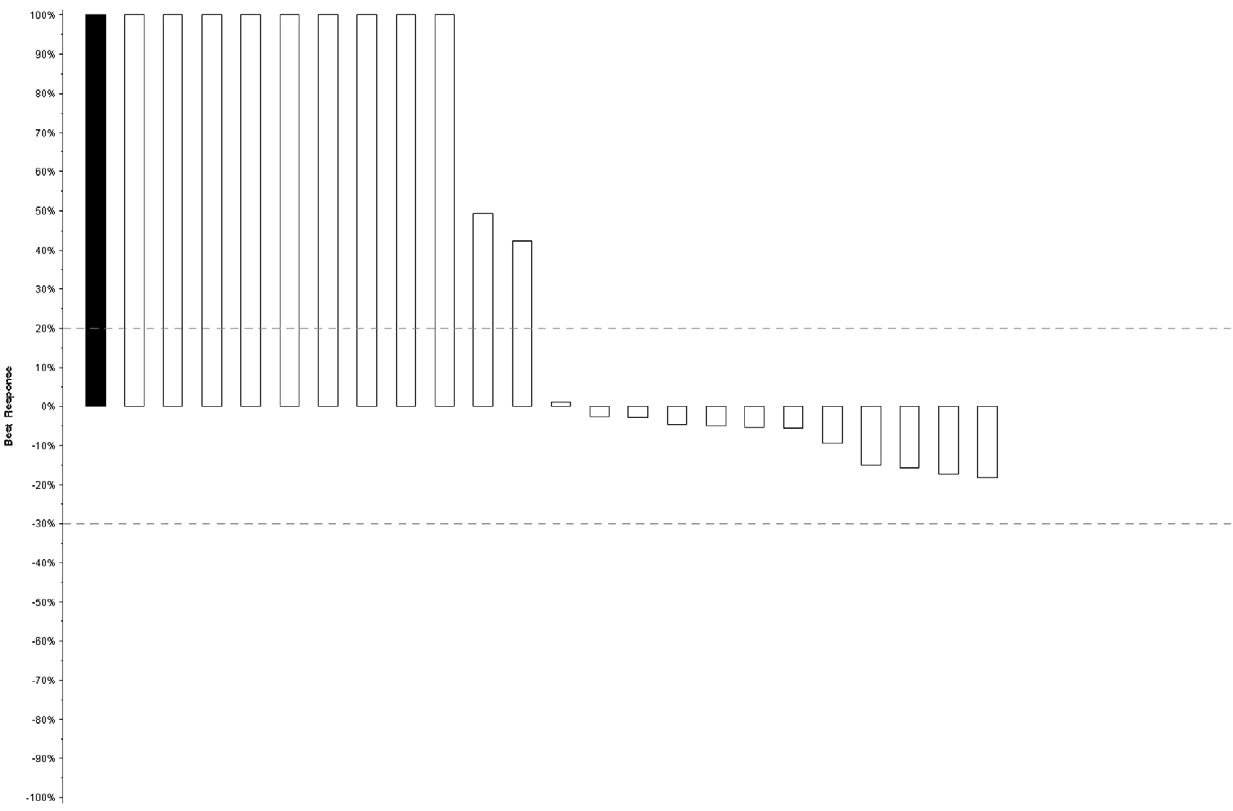
Figure 1. Best tumor response (waterfall plot) in evaluable patients (n=24). The bars on each plot represent the largest decrease under baseline of the sum of longest diameters of all target measurable lesions, or if no decrease was observed, the smallest increase in the sum of longest diameters of target measurable lesions. Patients whose best response was progression due to new lesions, death (due to disease), or clear worsening of non-measurable disease are represented by a bar showing a 100% increase. In addition, patients whose best response could not be determined due to inadequate assessment are represented on the far left side of the plot as a solid bar showing 100% increase.